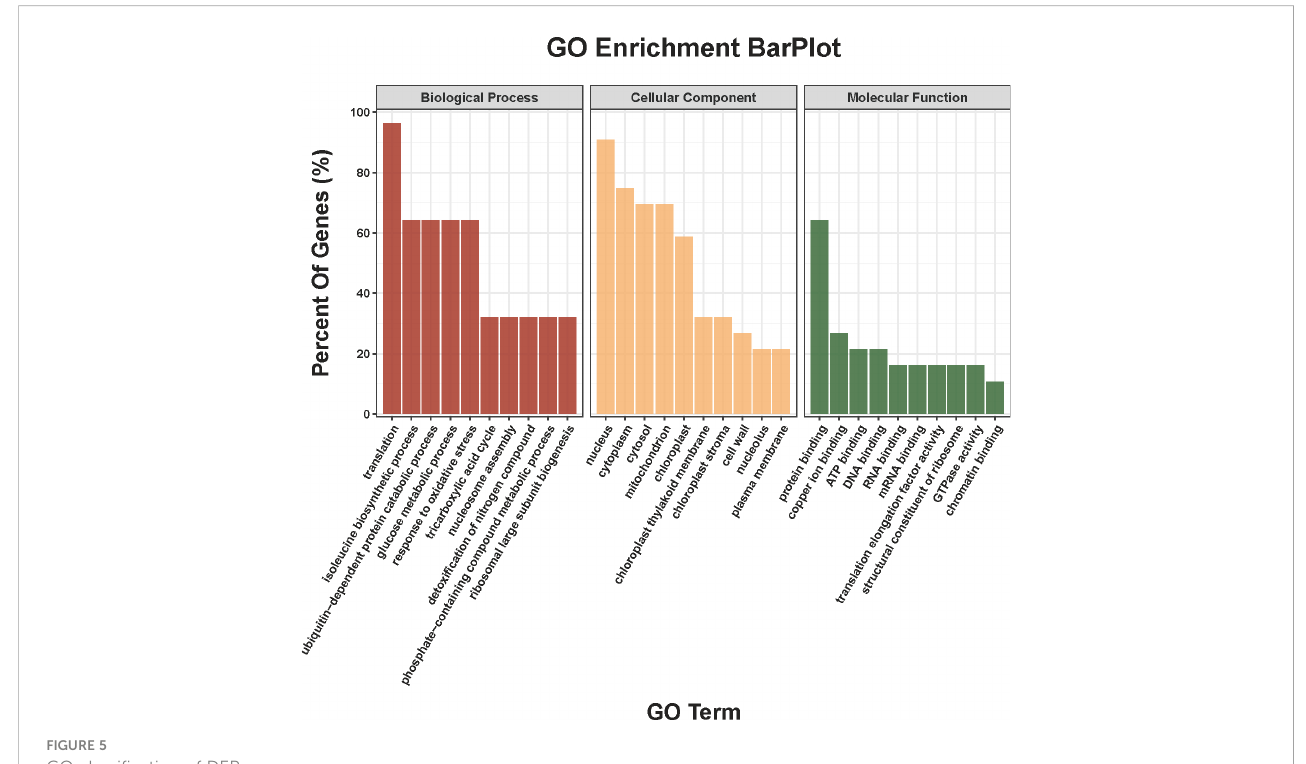
FIGURE 5 GO classi fi cation of DEPs.